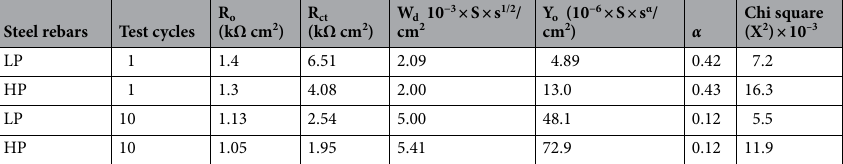
Table 3. Quantitative data extracted from the experimental EIS data for the rebars embedded in mortars using CPE model of the equivalent circuit presented in Fig. 18.